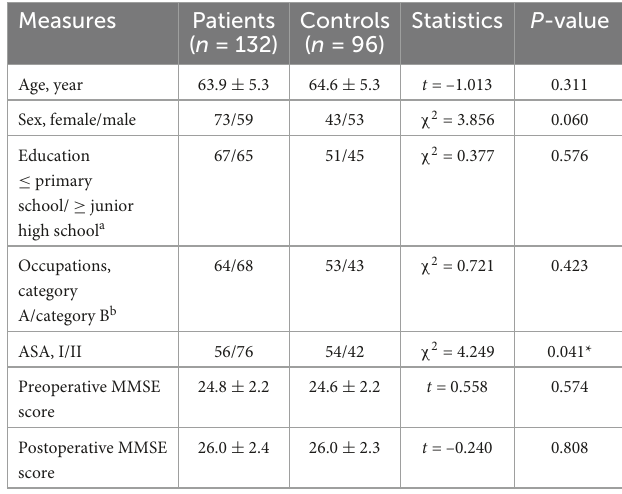
TABLE 1 Comparison of general data between patients and their families.